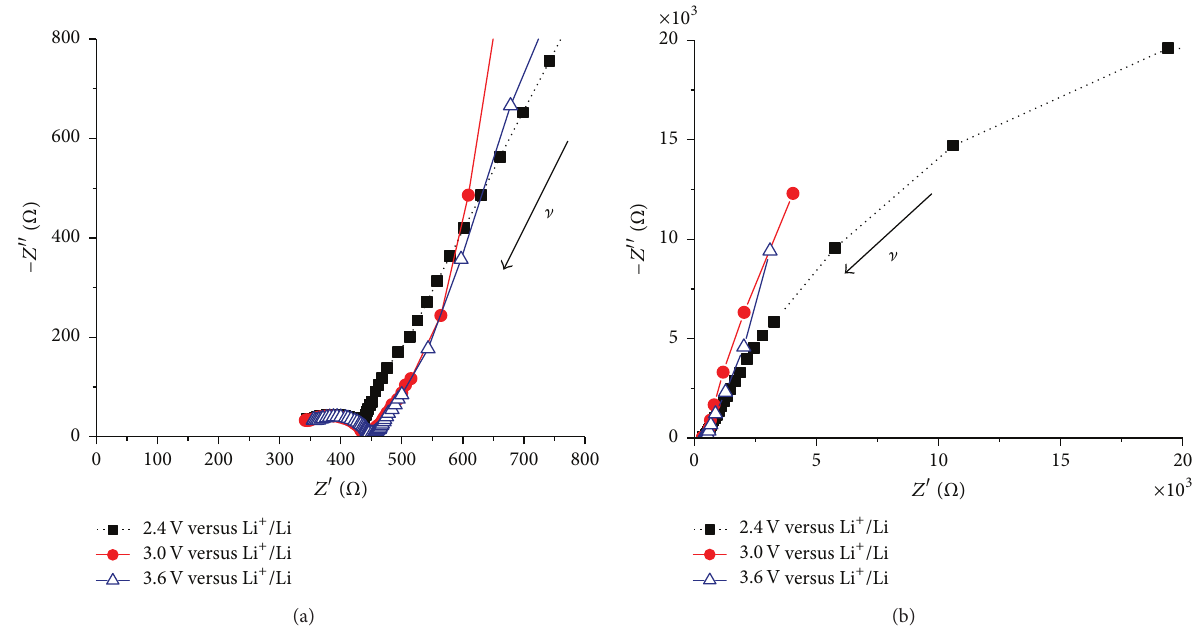
Figure 27: Electrochemical impedance spectra of ERY-sensitized RDS NiO Spectra have been recorded in dark conditions and displayed as Nyquist plots ((a) small scale; (b) large scale). NiO film thickness: 0.3 𝜇 m; substrate: ITO. Arrows indicate the direction of increase for the frequency of